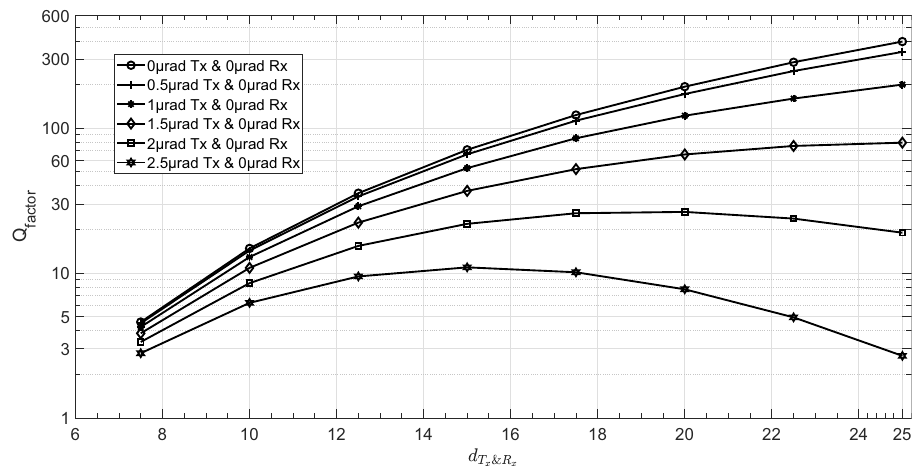
Figure 10: Quality factor ( Q factor ) as a function of telescope diameters ( cm ) for a di ff erent transmitter only pointing error.